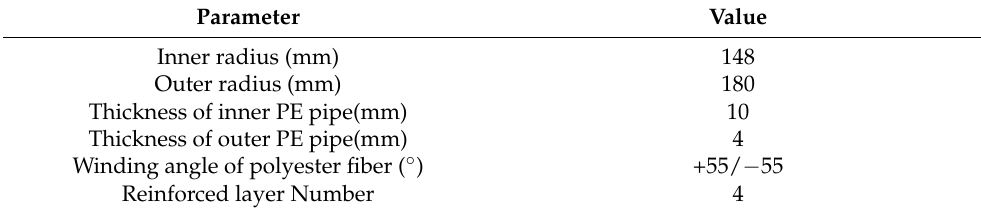
Table 1. The geometrical parameters of RTP.